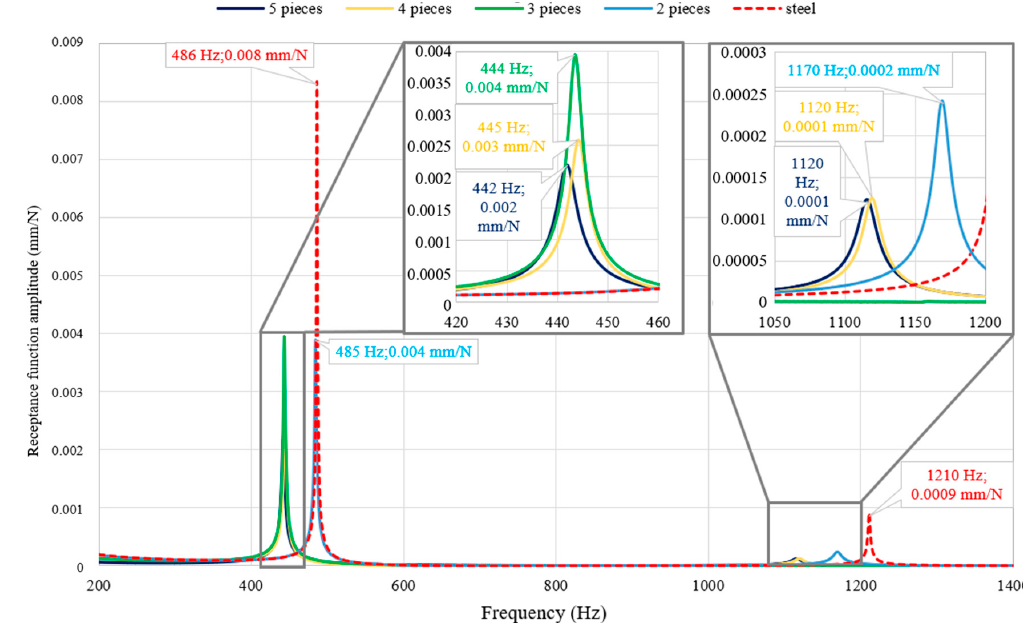
Figure 8. Comparison of the receptance functions for the partially covered beam with a different covers location. Table 5. Receptance function amplitudes for the first two resonances for partially covered beams.